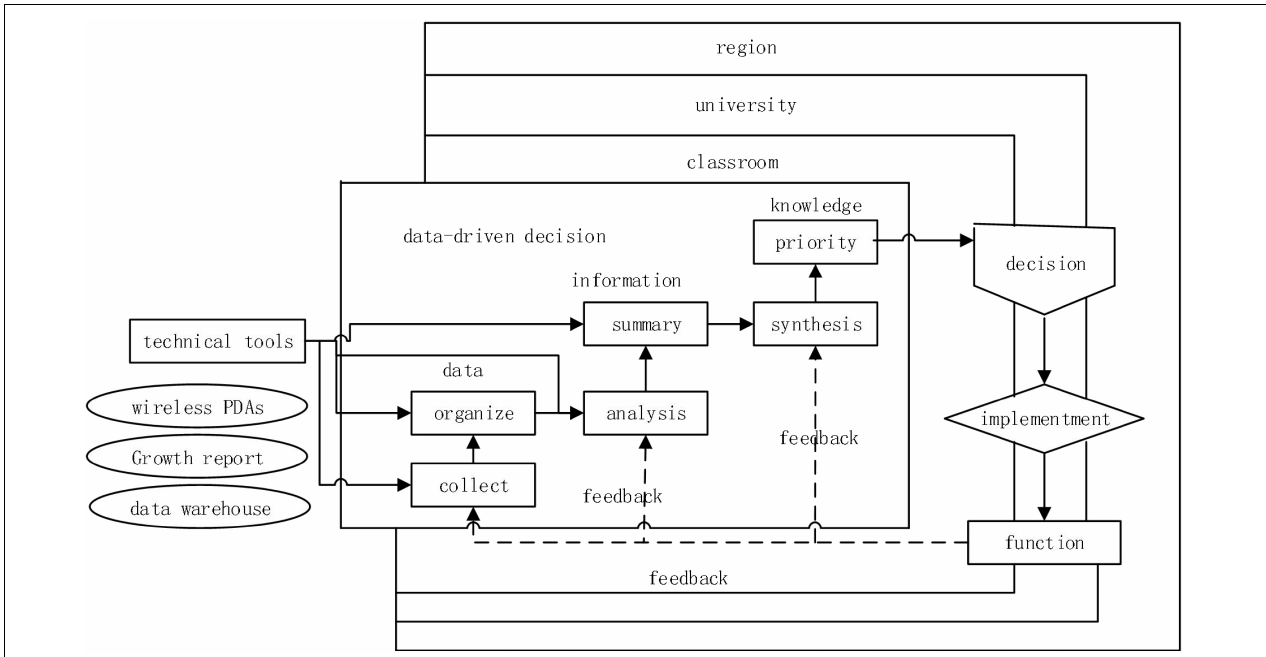
FIGURE 1 | Data-driven decision model of technical